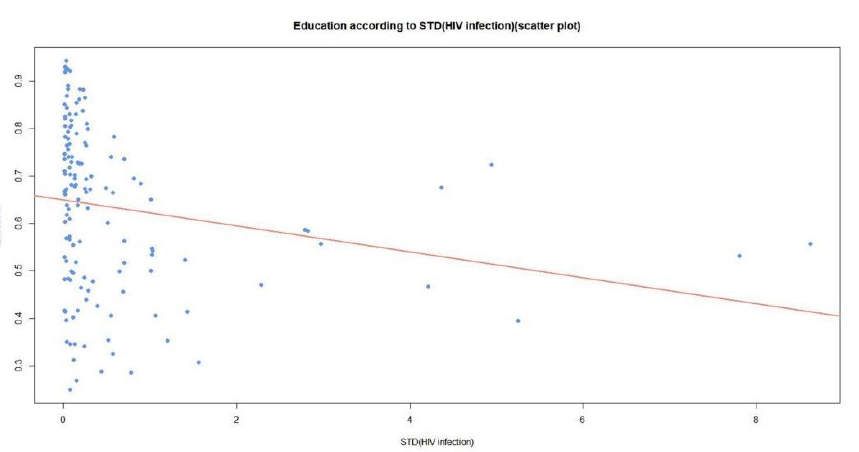
Figure 18. Scatterplot for STDs (HIV infection) and education.